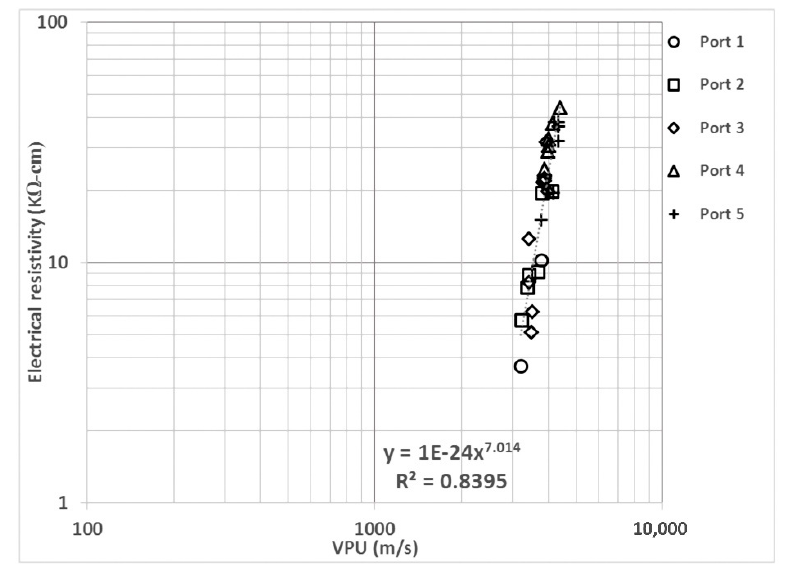
Figure 6. Electrical resistivity (ER) vs. ultrasonic pulse rate (UPV).